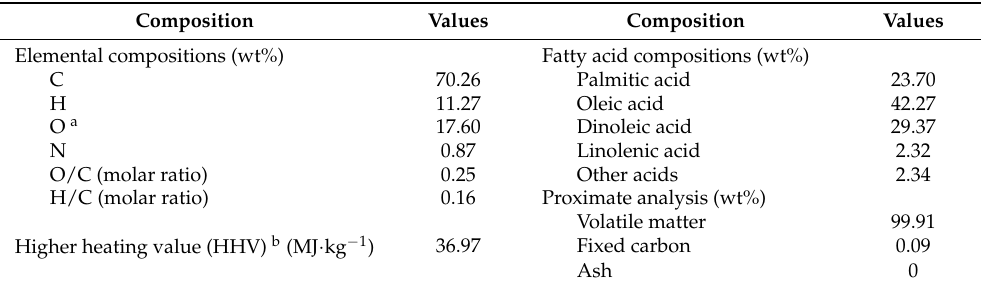
Table 3. Elemental analysis (wt%), HHV (MJ · kg − 1 ) and fatty acid compositions (wt%) of WCO-Biodiesel. Composition